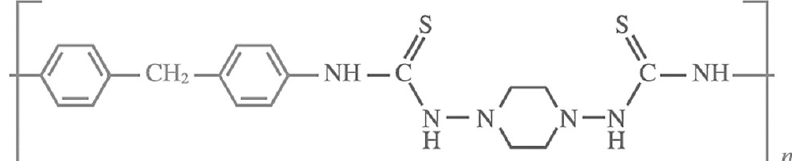
Figure 10. Schematic illustration of membrane synthesis using the counter-diffusion-based in situ method (adapted with permission from ref. [69]).